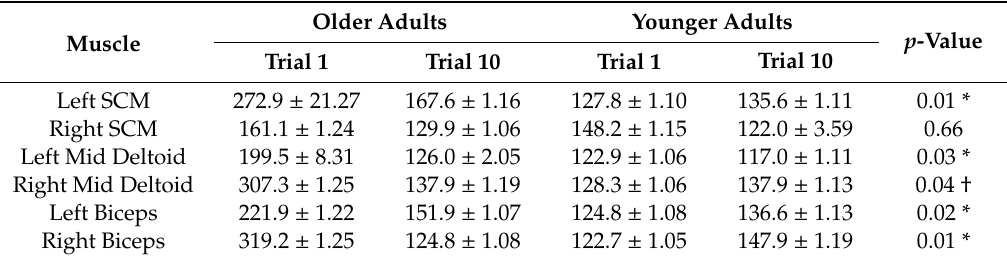
Table 2. Mean and standard error of time to peak EMG amplitude